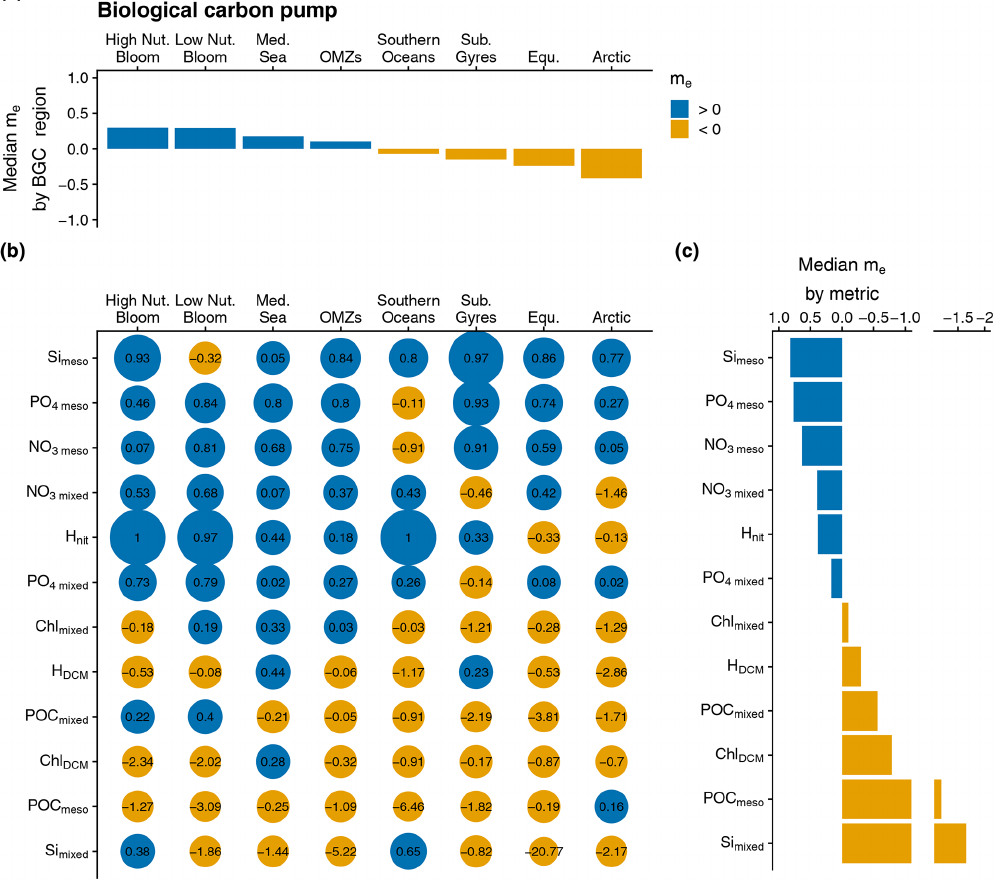
Figure 4. Same as Fig. 3 but for the assessment metrics associated with the biological carbon pump: depth-averaged Chl a in the mixed layer (Chl mixed ) , depth-averaged NO 3 in the mixed layer (NO 3mixed ) , depth-averaged PO 4 in the mixed layer (PO 4mixed ) , depth-averaged Si in the mixed layer (Si mixed ) , depth-averaged NO 3 in the mesopelagic layer (NO 3meso ) , depth-averaged PO 4 in the mesopelagic layer (PO 4meso ) , depth-averaged Si in the mesopelagic layer (Si meso ) , depth-averaged POC in the mixed layer (POC mixed ) , depth-averaged POC in the mesopelagic layer (POC meso ) , magnitude of the DCM (Chl DCM ) , depth of the DCM ( H DCM ) , and depth of the nitracline ( H nit )